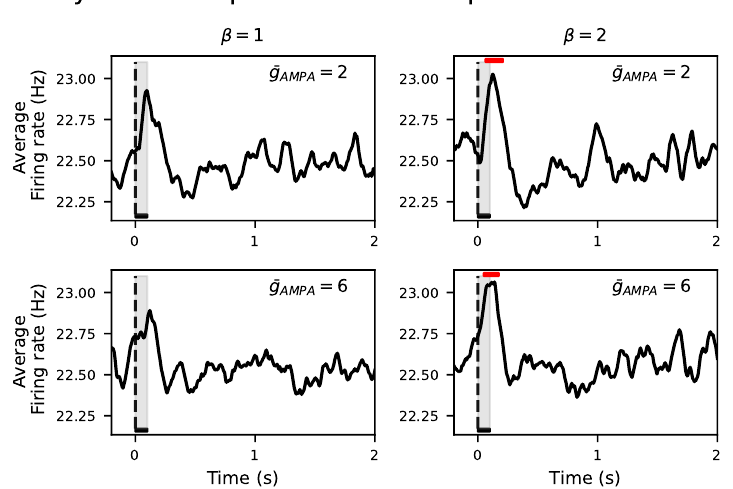
Figure 5. Evoked responses in the two-cortical-column model for β = 1, 2 and ¯ g AMPA = 2, 6. Average across 500 simulations of the firing rate of the unperturbed pyramidal population. Red horizontal bars show the location and length of significant t-cluster statistics when comparing the poststimulus versus the prestimulus interval. Firing rate of the unperturbed population shows a positive deflection after stimulus onset in all cases. Increasing ¯ g AMPA from 2 to 6 evokes a significant response ( p < 0.003) in the unperturbed population only if β is also increased from 1 to 2. In all cases, the dashed vertical line, aligned at zero, indicates stimulus ξ onset. Stimulus duration is represented by a black horizontal line and light gray